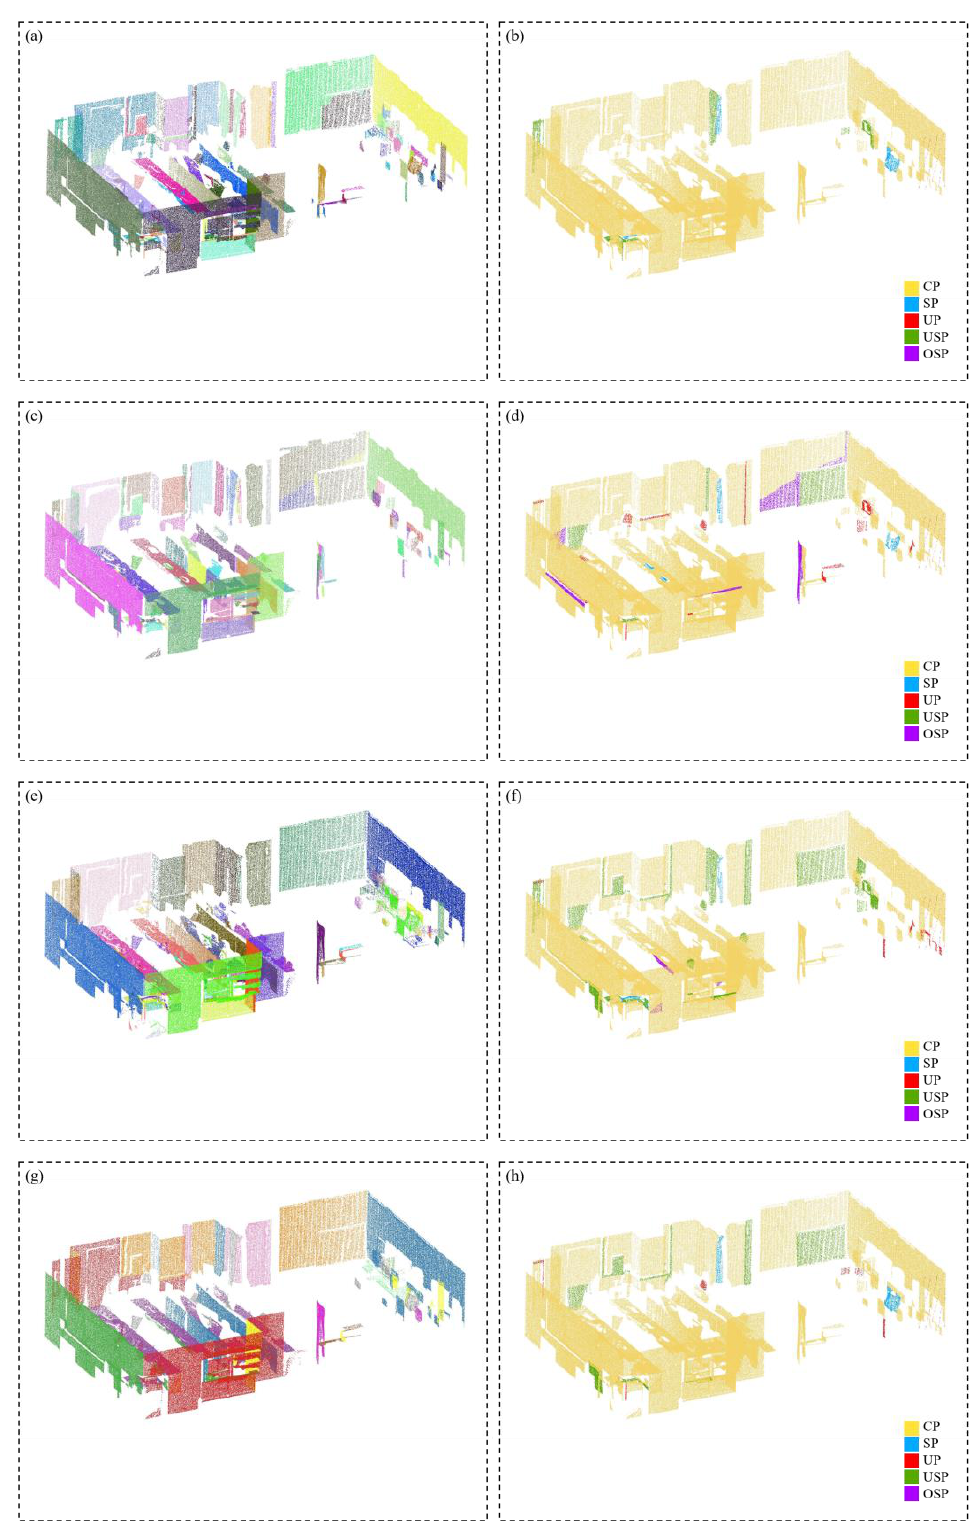
Figure 19. Comparison of plane-segmentation results of the Lab dataset: ( a , b ) proposed method and the main differences from ground truth, ( c , d ) RG and the main differences from ground truth, ( e , f ) efficient RANSAC and the main differences from ground truth, and ( g , h ) G-L 0 and the main differences from ground truth.